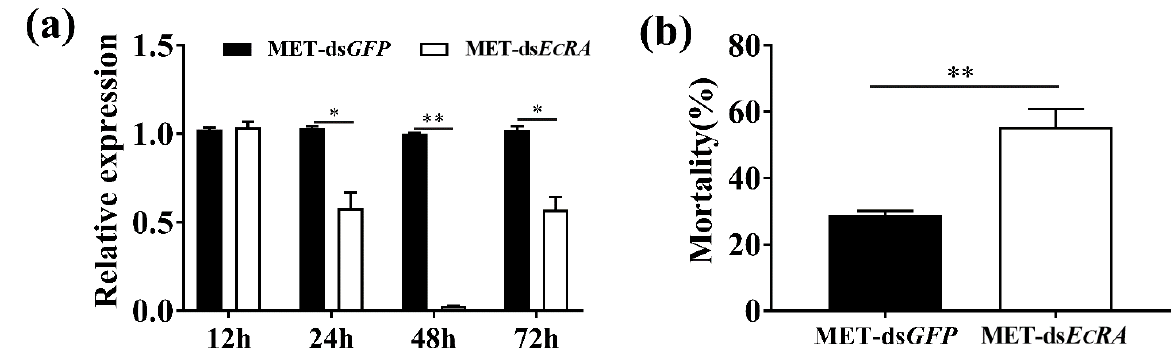
Figure 4. Knockdown of EcRA increases the sensitivity of S. exigua to MET. ( a ) Relative expression of EcRA ; ( b ) mortality (%) of the ds EcRA -treated S. exigua at 72 h after MET treatment. The columns represent averages, with vertical lines indicating SE. Significant differences were calculated by Student’s t -test (* p < 0.05; ** p < 0.01).